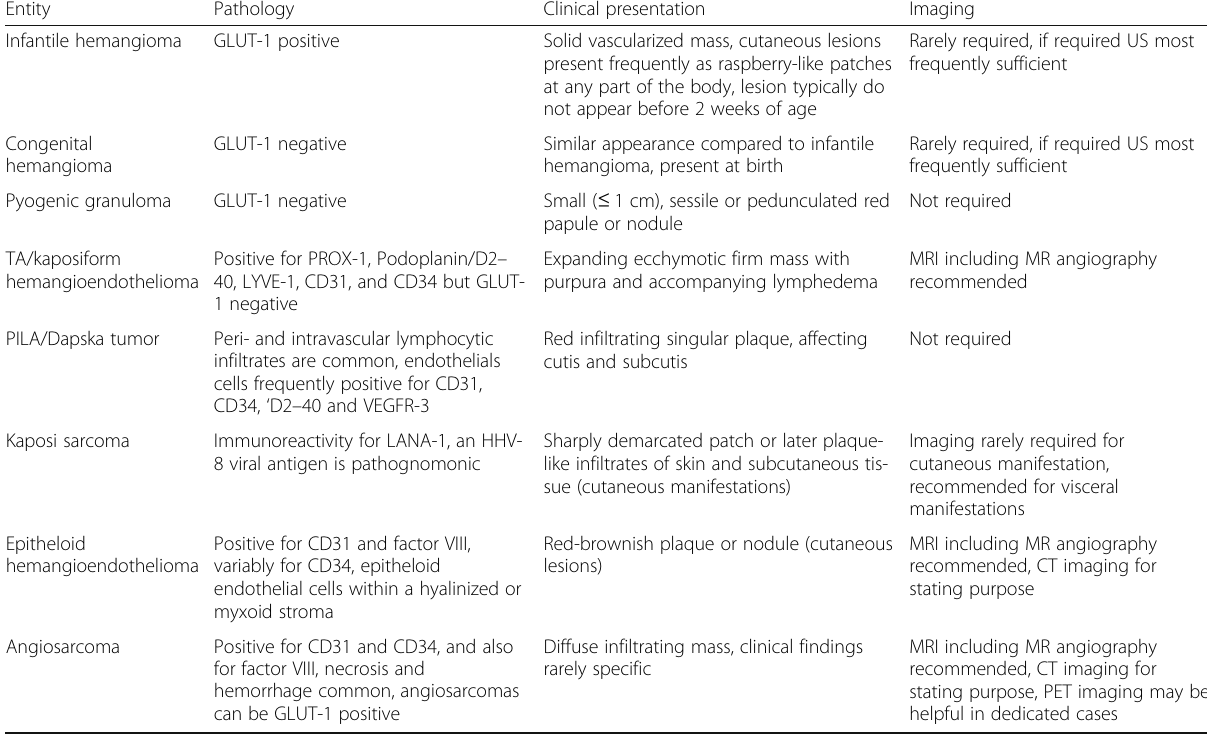
Table 2 Overview of the characteristics features and need for imaging of vascular tumors Entity Pathology Clinical